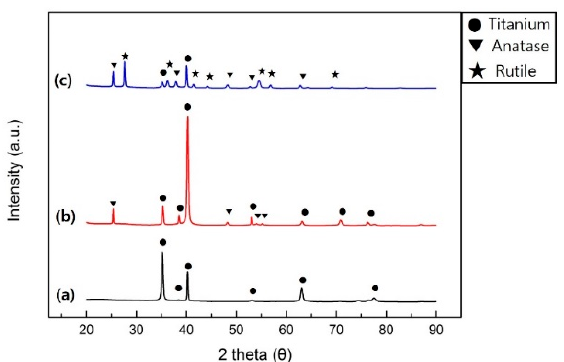
Figure 3. X-ray diffraction patterns of specimens. ( a ) H0, ( b ) H400, and ( c ) H600 samples.